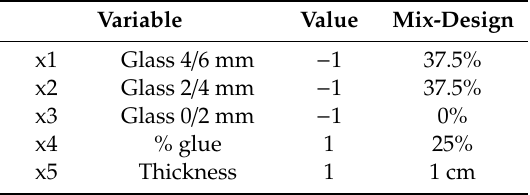
Table 9. Mix-design to maximize the toughness of the semi-transparent layer.